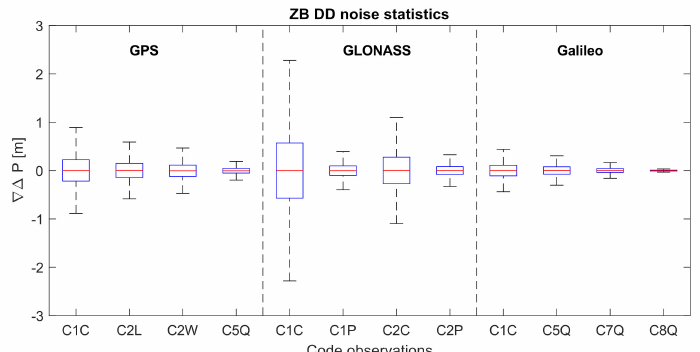
Figure 2. ZB DD time series noise statistic for code observations (2019 DOY:055).